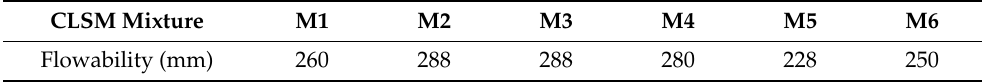
Table 4. Flowability of the CLSM mixtures with six different fly ashes.